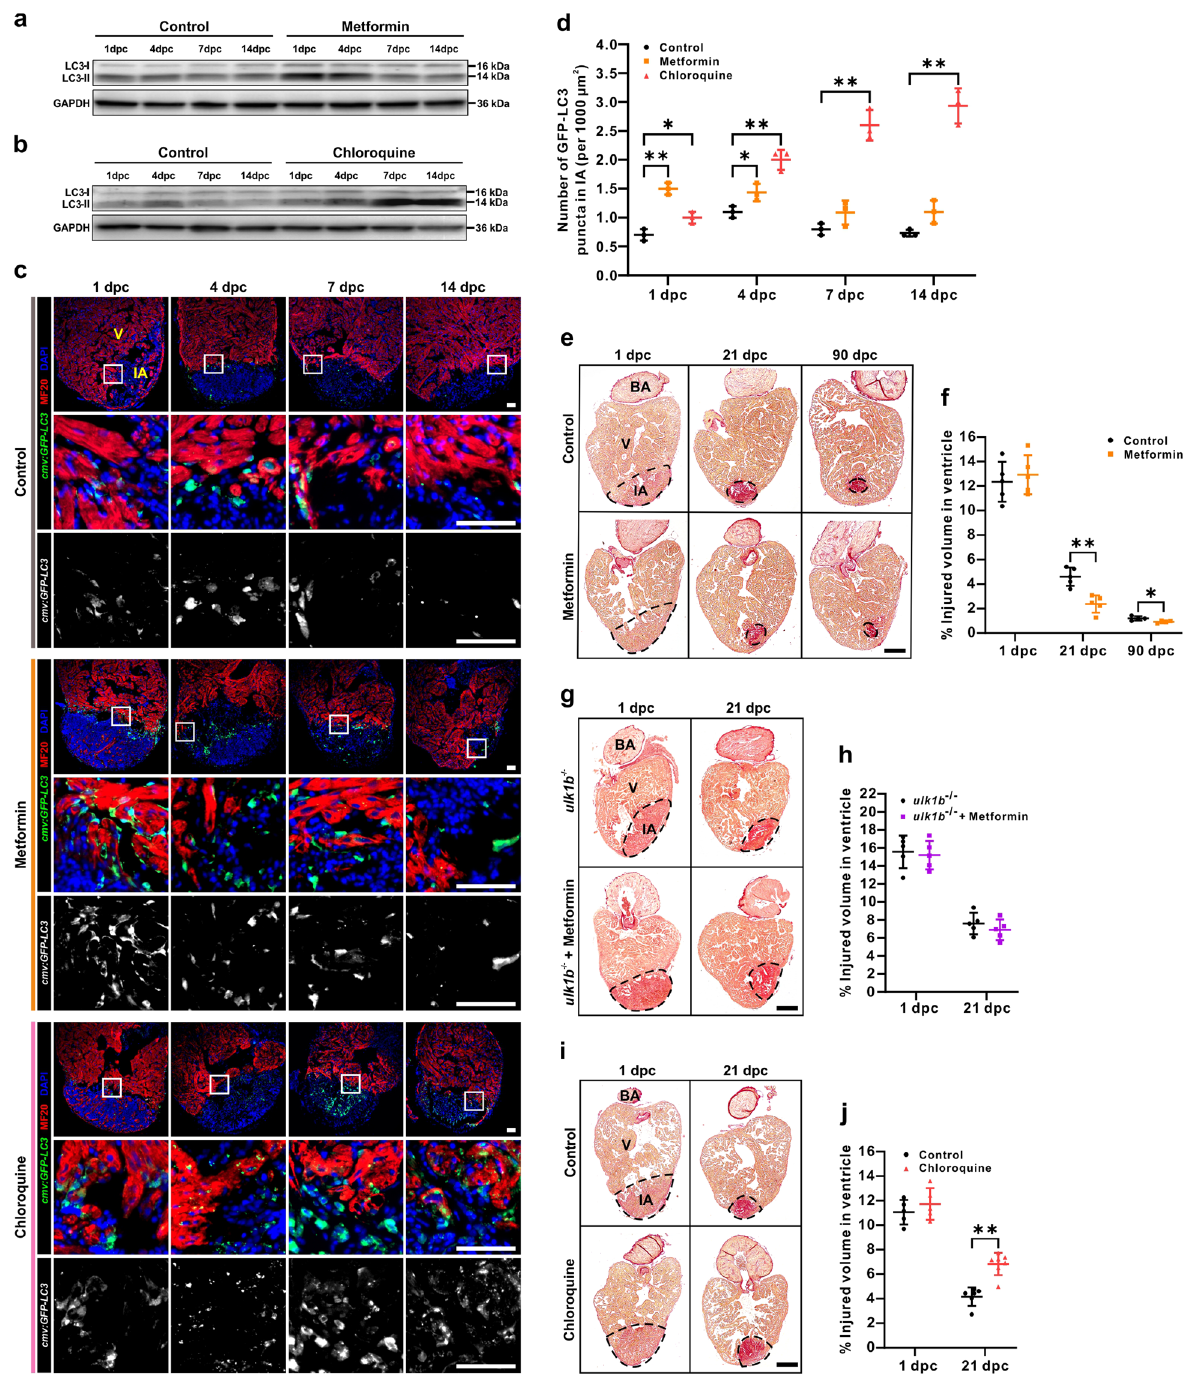
Fig. 2 Metformin enhances the autophagic fl ux and accelerates heart regeneration. a , b Western blot analysis was performed in cryoinjured hearts treated with or without 50 µM metformin ( a ) or 100 µM CQ ( b ) to detect the expression of LC3-I and LC3-II from 1 to 14 dpc. The protein from three hearts was loaded into each lane, and GAPDH was used as the loading control. c , d After cryoinjury, the heart of Tg ( cmv : GFP-LC3 ) fi sh treated with or without 50 µM metformin or 100 µM CQ, were isolated, fi xed, sectioned and dual-immunostained with anti- GFP (green) and anti-MF20 (red), after which they were stained with DAPI (blue). IA: injured area; V: ventricle. Scale bars: 50 µm ( c ). The number of GFP-LC3 puncta in the injured area at 1 dpc, 4 dpc, 7 dpc, and 14 dpc was quanti fi ed. The data are presented as mean ± SD, n = 3 hearts, * P < 0.05, ** P < 0.01 vs control ( d ). e – j Following cryoinjury, the AB fi sh were either untreated (control) or else they were treated with 50 µM metformin for up to 90 days ( e , f ), or they were treated with 100 µM CQ for up to 21 days ( i , j ); the ulk1b mutant fi sh generated by TALEN were also either untreated (control) or else they were treated with 50 µM metformin for up to 21 days ( g , h ). Paraf fi n sections were then prepared and stained with Picro Sirius red. BA: bulbous arteriosus. Scale bars: 200 µm. The injured volume percentage was then quanti fi ed in the ventricle of the control and metformin ( f , h ) or CQ ( j ) treatment groups at the different time points. The data are presented as mean ± SD, n = 4 to 7 hearts, * P < 0.05, ** P < 0.01 vs